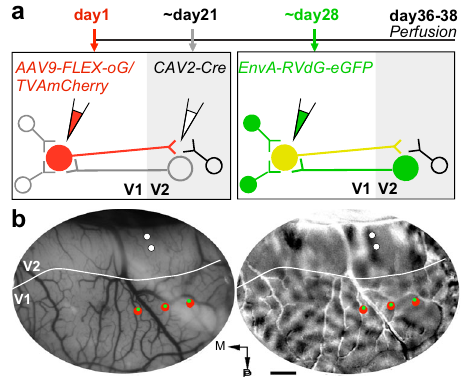
Fig. 1 Monosynaptic input tracing in macaque visual cortex: experimental design. a Viral injection timeline and experimental design. Left: V1 → V2 neurons express mCherry (red cells), TVA, and oG, after double infection with AAV9-vectors (injected in V1) and CAV2-Cre (injected in V2). Right: After additional infection with EnvA-RV dG -eGFP (injected at the same V1 sites as AAV9), V1 → V2 neurons previously infected with AAV9 additionally express eGFP, becoming double-labeled (yellow starter cells).